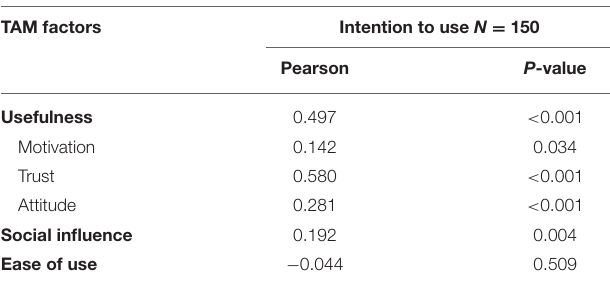
TABLE 3 | The relation between the TAM factors and the intention to use e-consultations among the total study